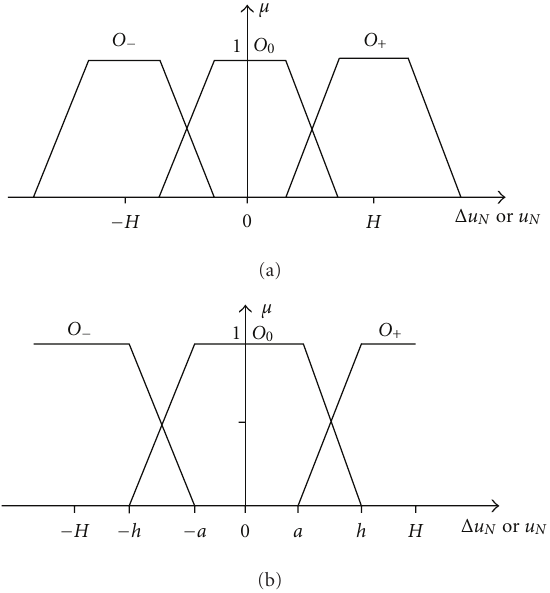
Figure 1: Output membership